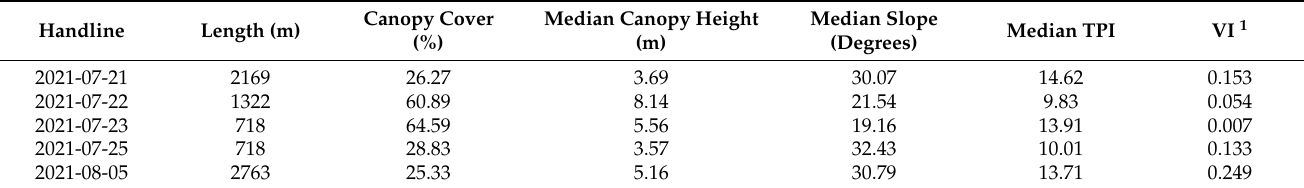
Table 4. Summary of handline